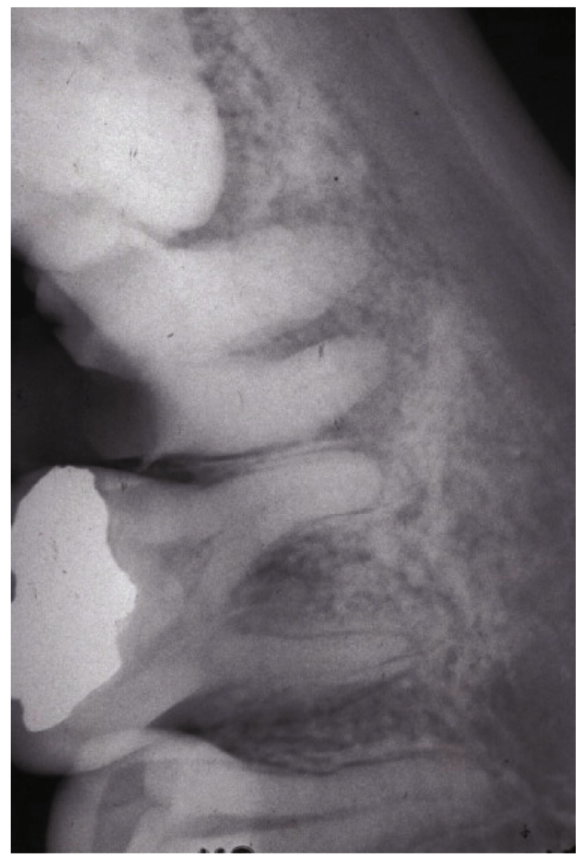
Figure 1: The initial clinical presentation of #18 with gross caries extending to the subgingival margin.